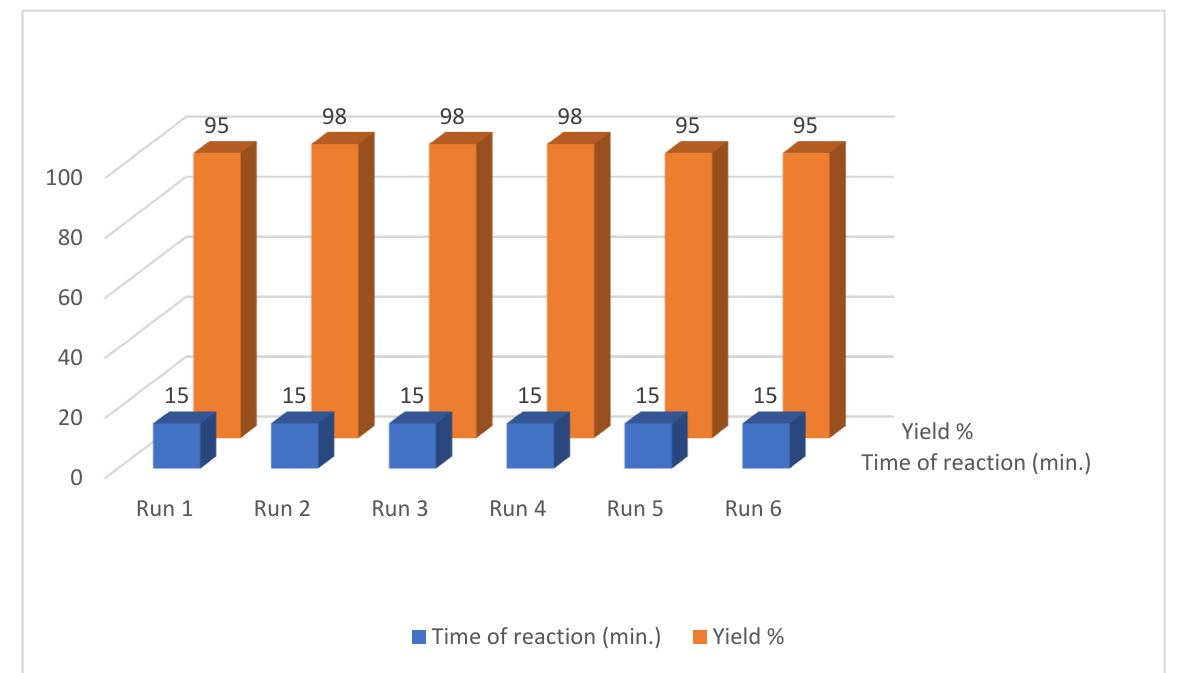
Figure 9. Reusability of the Ni-Mg-Fe LDH catalyst for synthesis of 5a .